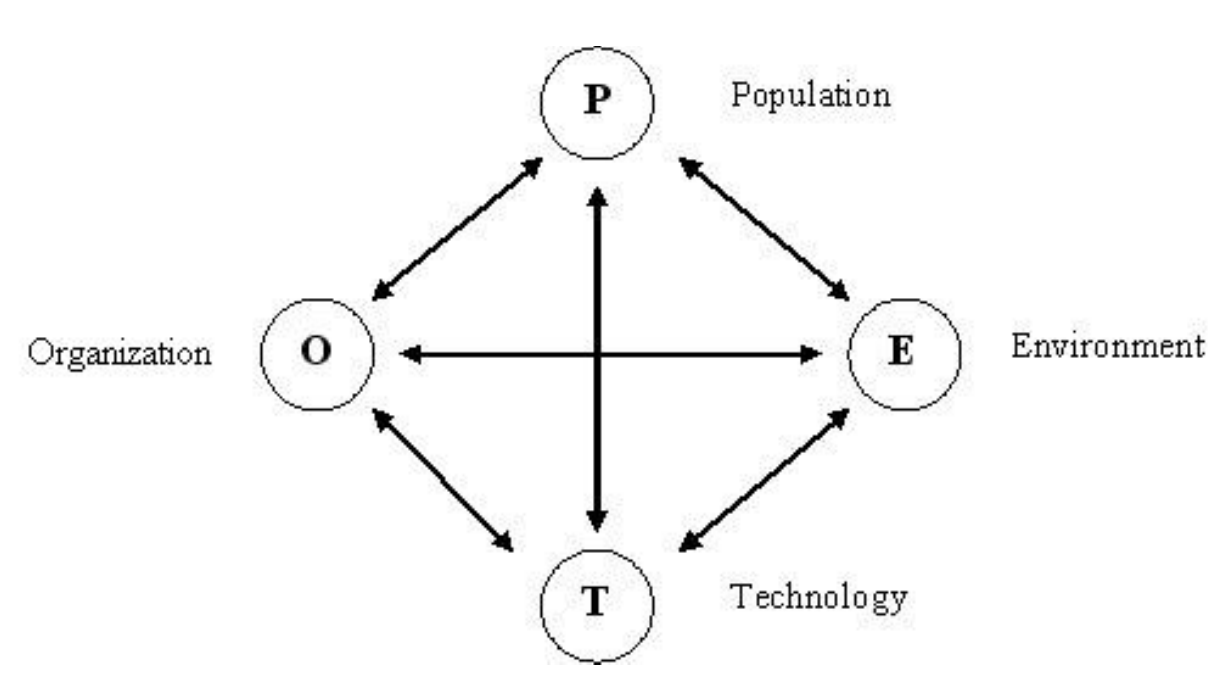
Fig. 1. Duncan’s POET model of the ecological complex (Duncan 1961,